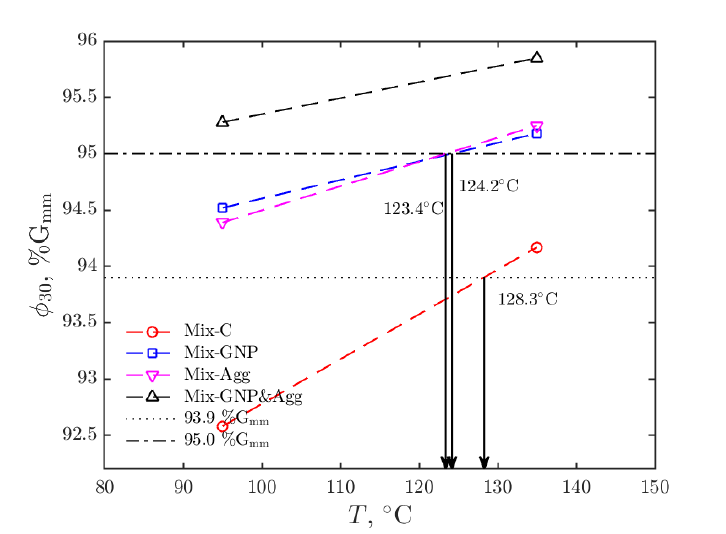
Figure 11. Estimation of the compaction temperatures by the linear model.